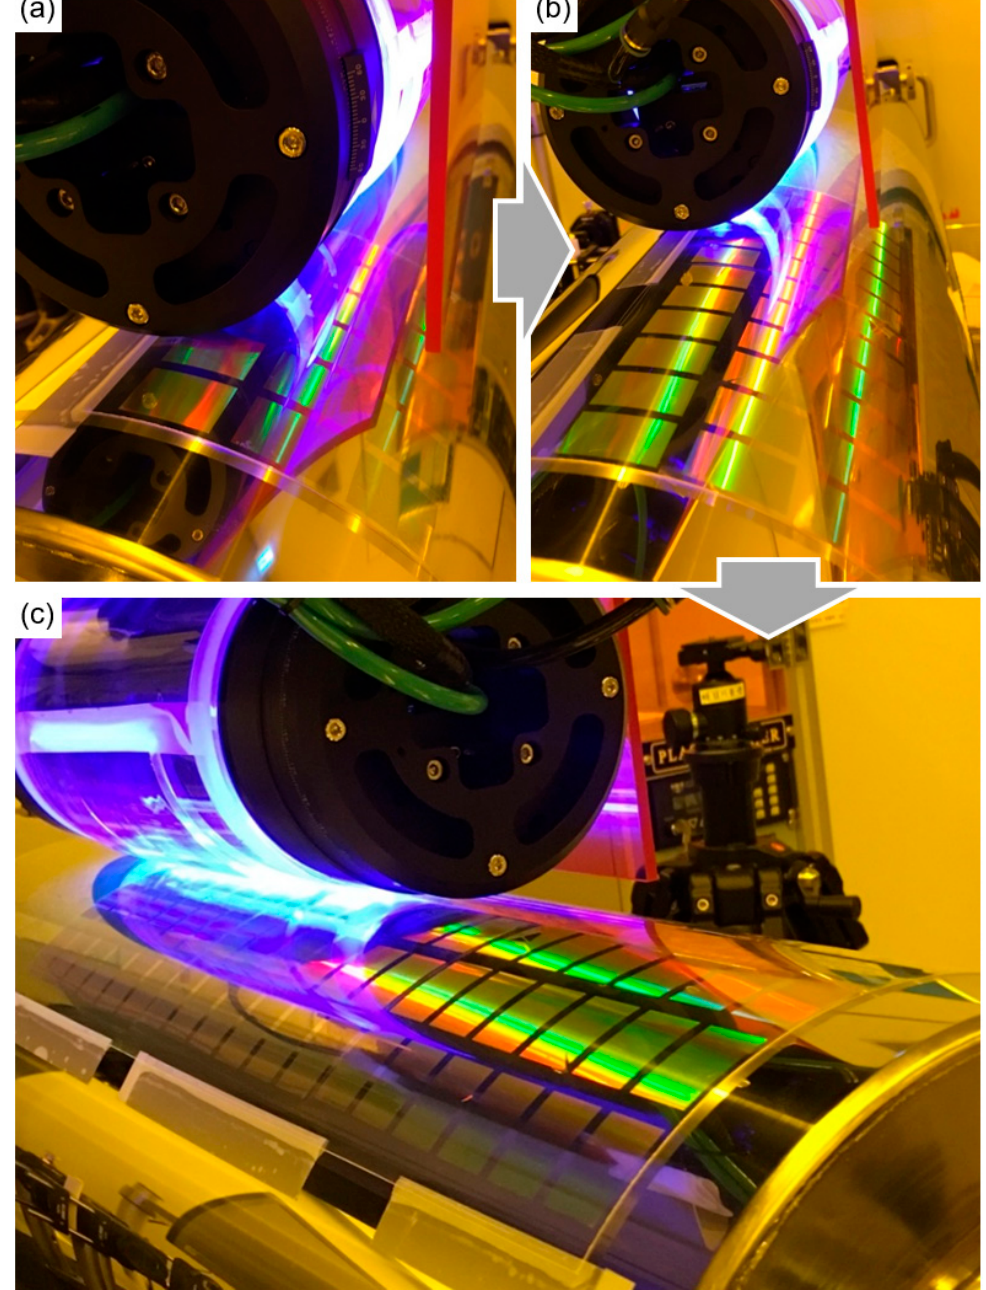
Figure 6. Photographs of the system and the patterned acceptor roll during ( a ) the first, ( b ) second and ( c ) third steps of the transfer process in longitudinal direction under the UV light illumination.